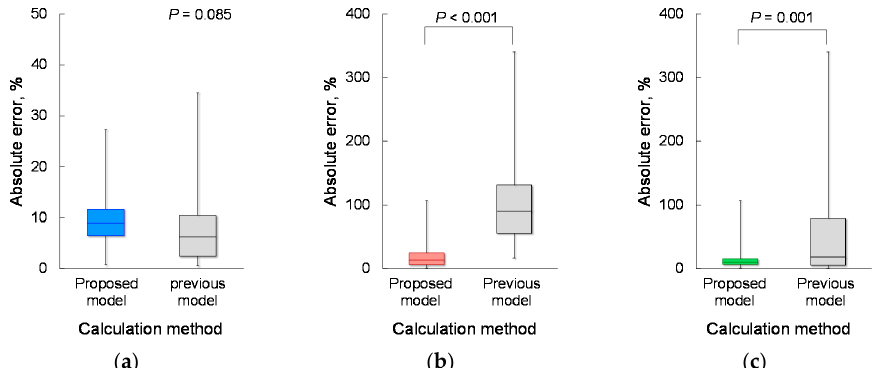
Figure 5. Comparison of the absolute error between the proposed and previous models. ( a ) Young participants, n = 33. ( b ) Elderly participants, n = 25. ( c ) All participants, n = 58.